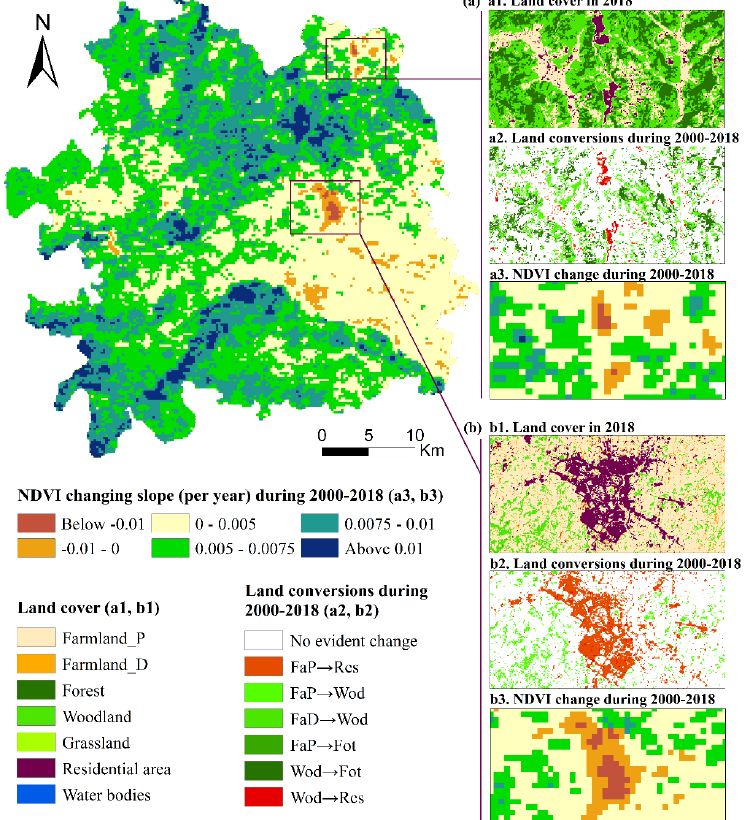
Figure 5. The spatial distribution of annual NDVI changing slope during 2000–2018; ( a ) the comparison between the patterns of land cover, land conversions and NDVI change for a rural residential region; ( b ) the comparison between the patterns of land cover, land conversions and NDVI change for the urban area (Notes: The same as Table 2).